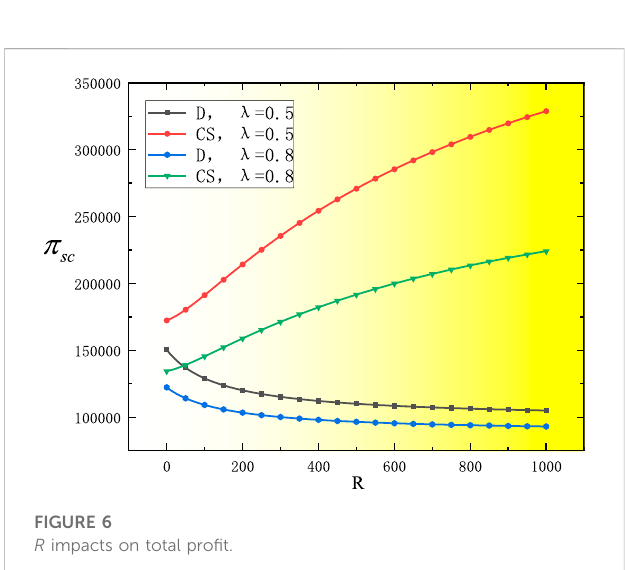
FIGURE 6 R impacts on total pro fi